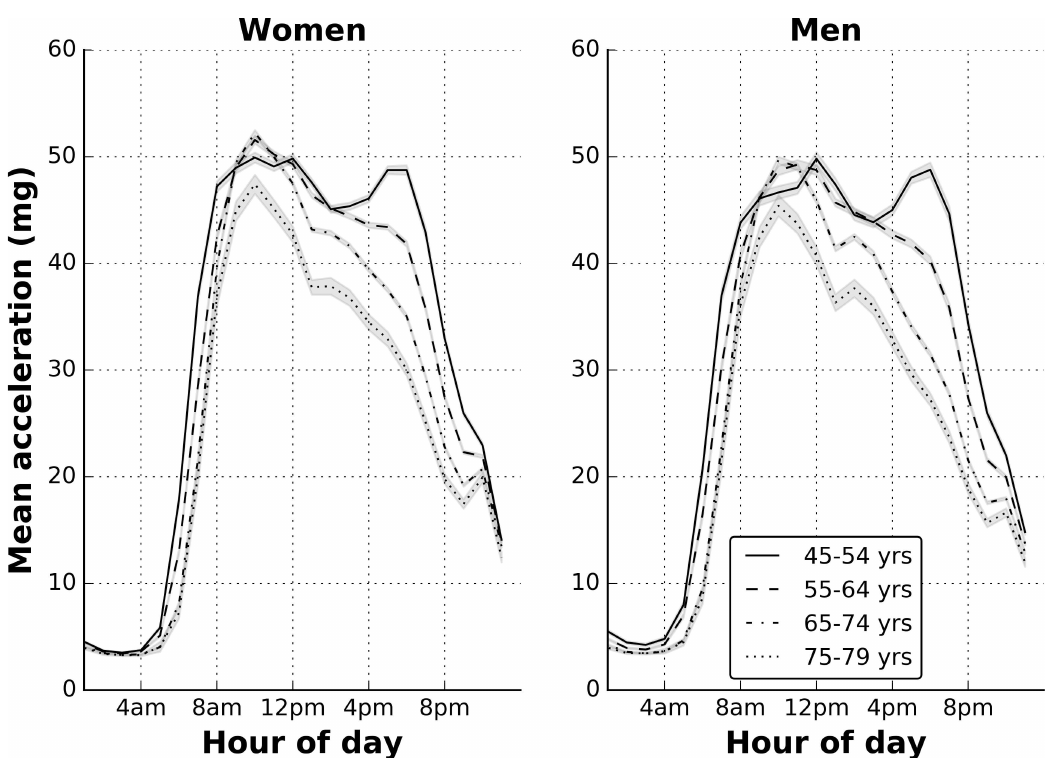
Fig 5. Variation in mean acceleration across the day by age and sex: the UK Biobank study 2013–2015 (n = 96,600). Shadingboundsrepresent two standard